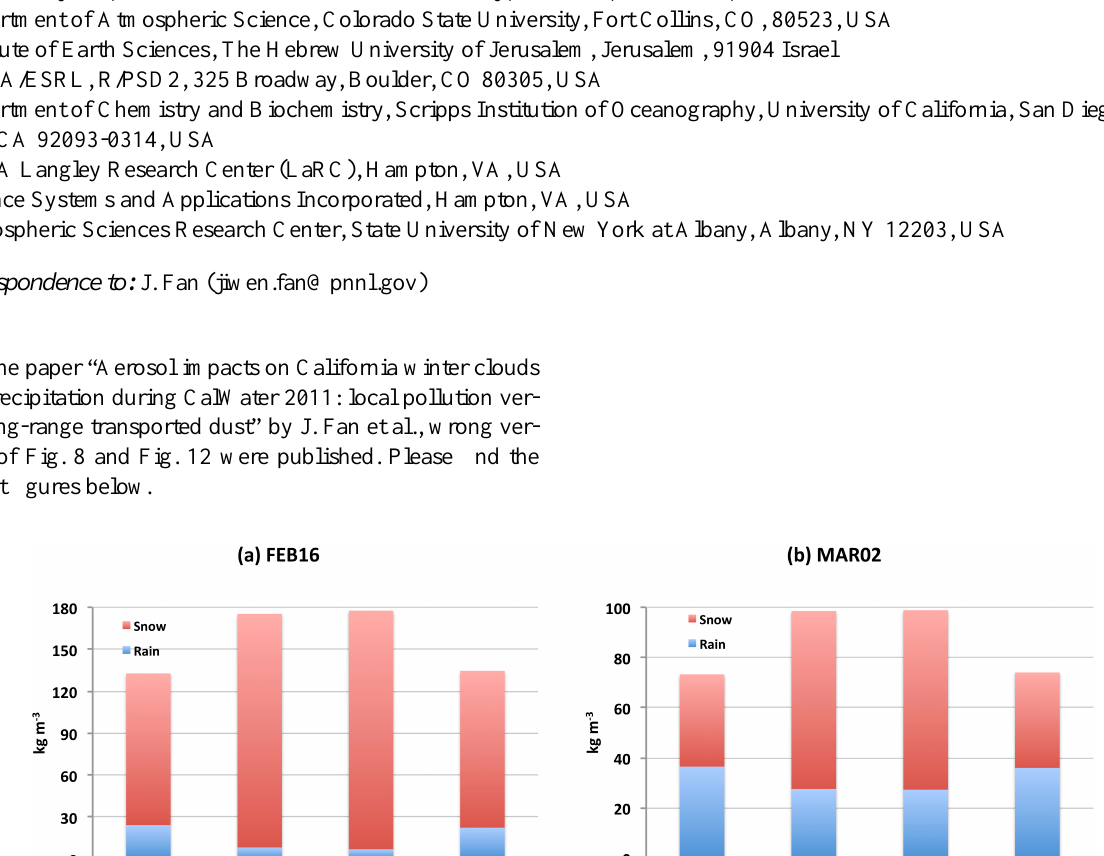
Published by Copernicus Publications on behalf of the European Geosciences